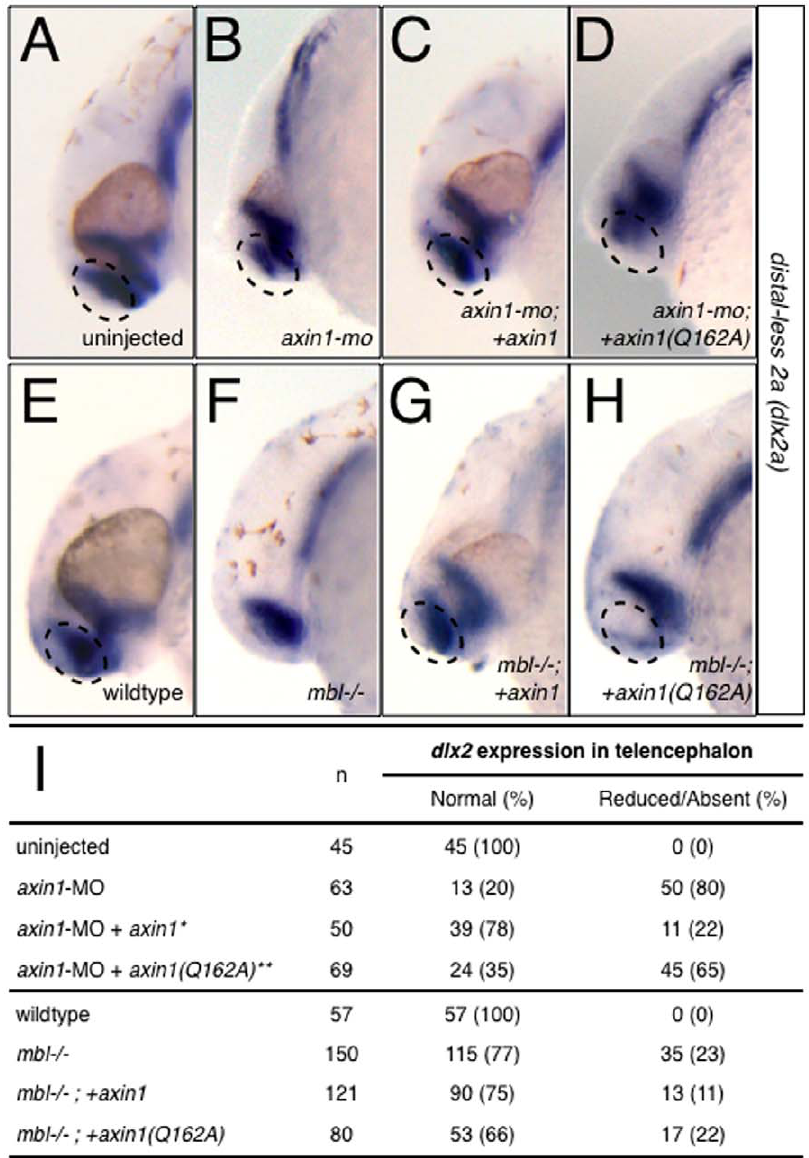
Figure 7. axin1 but not axin1(Q162A) rescues telencephalic defects in Axin1-depleted and in mbl 2 / 2 embryos. ( A–H ) Representative examples of dlx2 expression in control and Axin1-depleted zebrafish embryos (A–D) and in wildtype and mbl 2 / 2 embryos (E–H). ( A ) control uninjected embryo at 24 hpf, ( B ) axin1- MO-injected, ( C ) axin1 -MO + xx axin1 , ( D ) axin1- MO + axin1(Q162A) , ( E ) wildtype embryo at 24 hpf, ( F ) mbl 2 / 2 , ( G ) mbl 2 / 2 ; + axin1 ( H ) mbl 2 / 2 ; + axin1(Q162A) . ( I ) Summary of dlx2 expression data. Arrows indicate areas of reduced or absent dlx2 in the telencephalon.